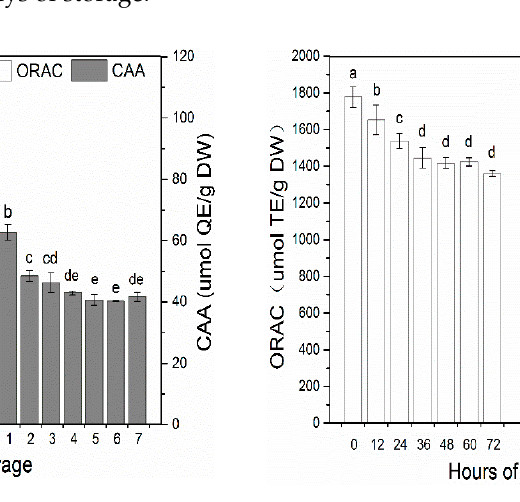
Figure 3. Changes of oxygen radical absorbance capacity (ORAC) and cellular antioxidant activity (CAA) antioxidant activity of litchi pericarp stored at 4 °C ( A ) and at RT (27 ± 2 °C) ( B ). Values are expressed as mean ± SD ( n = 3). Bars with no letters in common are significantly different, p < 0.05.